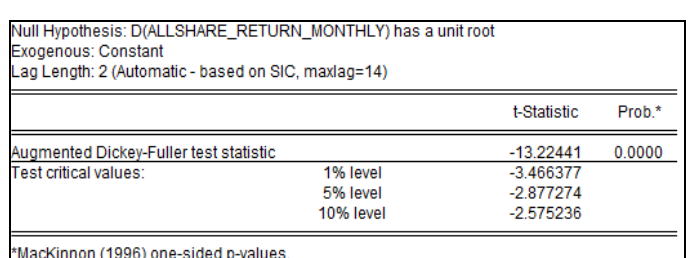
FIGURE 2: Augmented Dickey-Fuller (ADF) Test - Level Source: Eviews